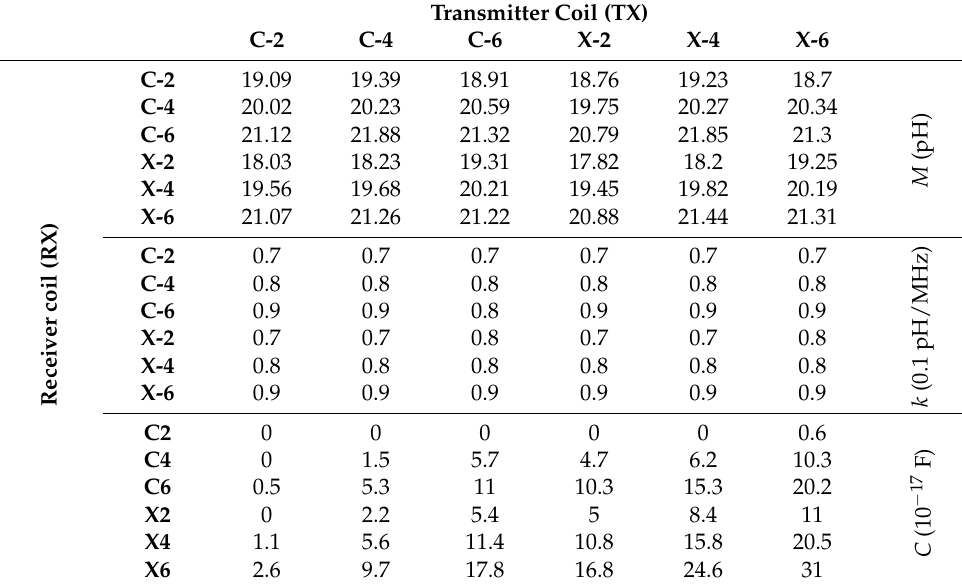
Table 4. Model parameters, 37 cm intercoil